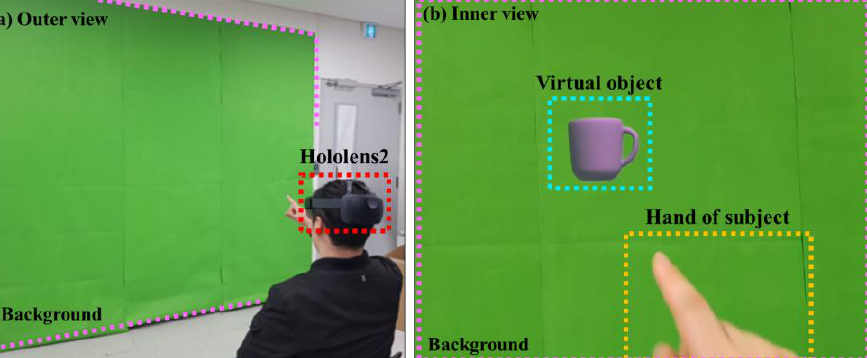
Figure 7. Subject ’ s two views of subject in MR experiment: outer view and inner view through Hololens2: ( a ) outer view, ( b ) inner view.